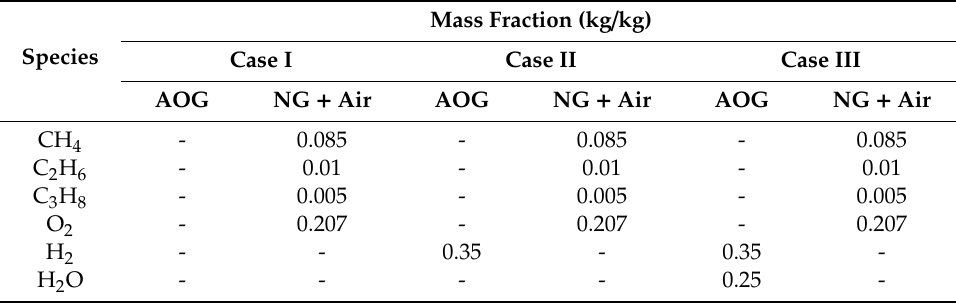
Table 4. Species mass fractions at the inlet used in the simulations for all the three cases. Mass Fraction (kg / kg) Species Case I Case II Case III AOG NG + Air AOG NG + Air AOG NG + Air CH 4 - 0.085 - 0.085 - 0.085 C 2 H 6 - 0.01 - 0.01 - 0.01 C 3 H 8 - 0.005 - 0.005 - 0.005 O 2 - 0.207 - 0.207 - 0.207 H 2 - - 0.35 - 0.35 - H 2 O